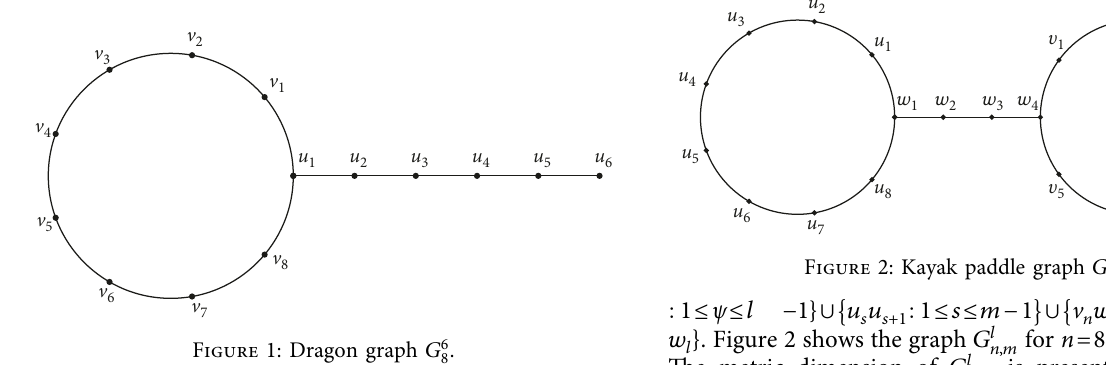
Figure 1: Dragon graph G 6